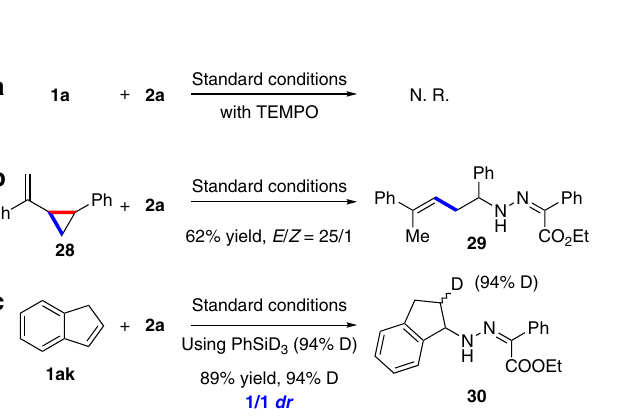
Fig. 4 Mechanistic studies. a Radical trapping experiment. b Radical clock experiment. c Deuterium-labeling experiment. TEMPO, 2,2,6,6- tetramethylpiperidine-1-oxyl. Fig. 5 Proposed mechanism. Cobalt-induced HAT generates carbon